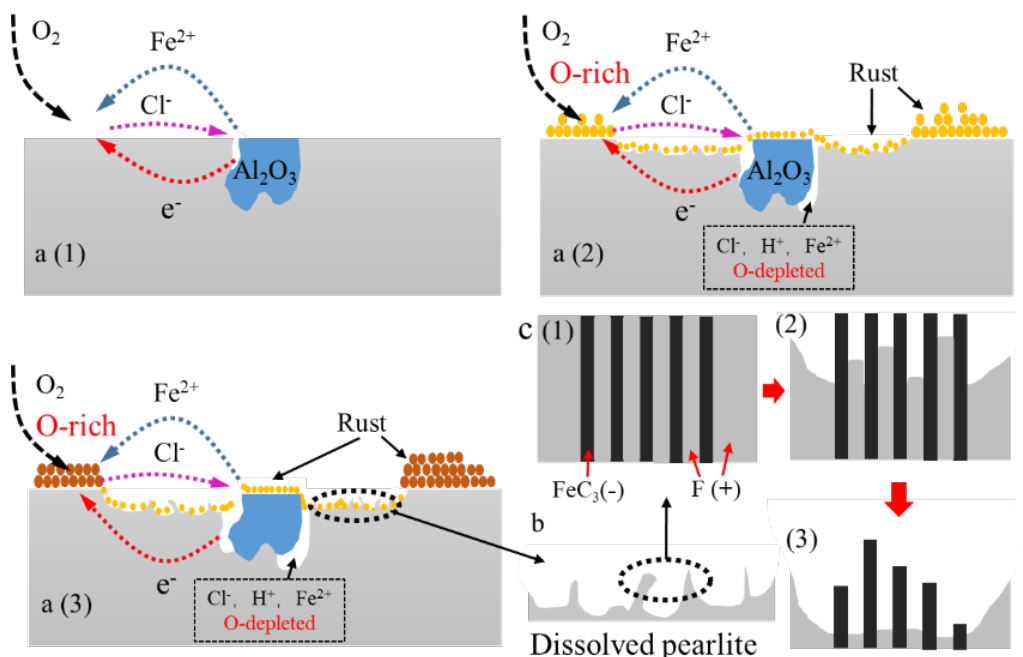
Figure 12. ( a ) Schematic of the localized corrosion initiation and evolution process; and ( b ) diagram of the dissolved pearlite morphology; ( c ) Schematic of the pearlite dissolution process.